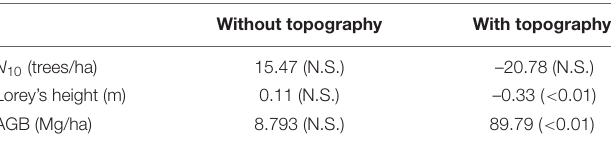
TABLE 1 | Slope estimates of linear models of each simulated quadrat-level forest structure metrics to the wind speed correction factor, with p-values in